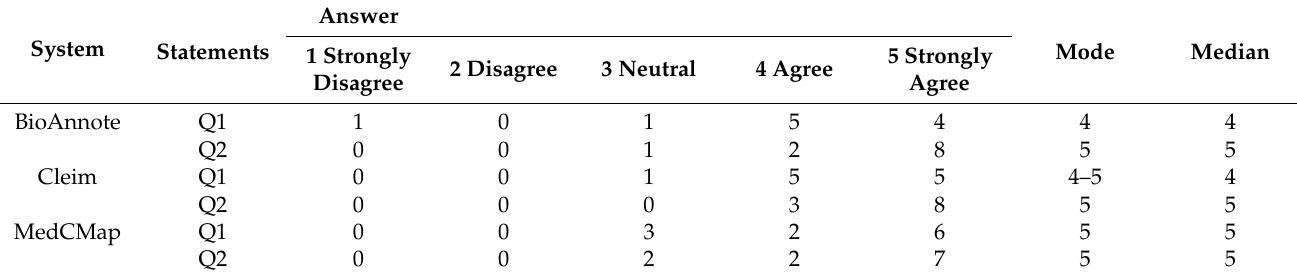
Table 3. Subjective perceptions of the BioAnnote, CLEiM and MedCMap systems.